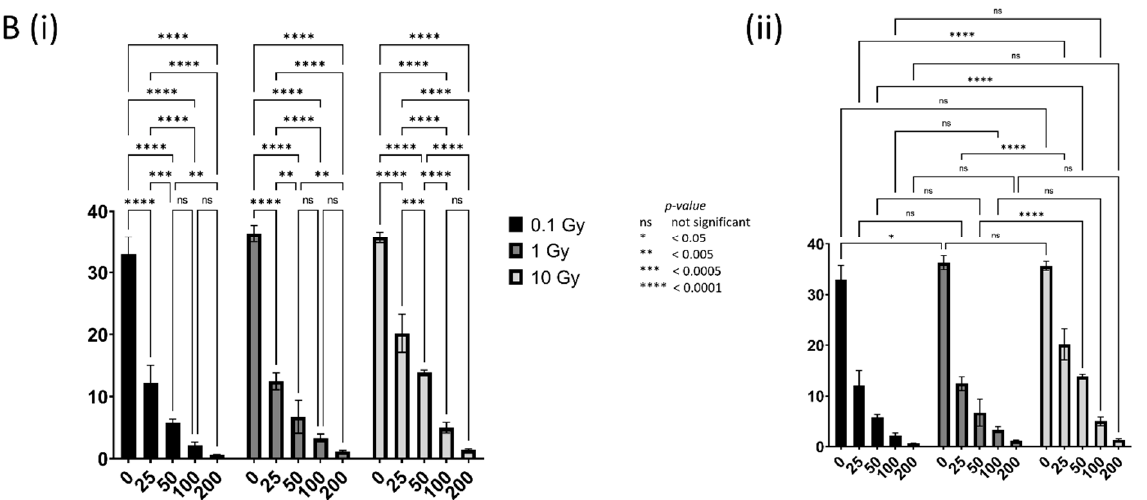
Figure 4. Concentration-dependent modulation of reactive oxygen species by CeO 2 nanoparticles in MDA MB231 breast carcinoma cells following irradiation with ionizing radiation. ( A ). Flow cytometric profiles of 10 µ M DHR123 labeled cells, not irradiated or irradiated with 0.1, 1, and 10 Gy ionizing radiation following treatment with 0, 25, 50, 100, or 200 µ g mL − 1 nanoceria. ( B ). A two-way ANOVA compares background-subtracted median fluorescent intensities in the FL1 subpopulations ( i ) within and ( ii ) in-between treated, irradiated sample